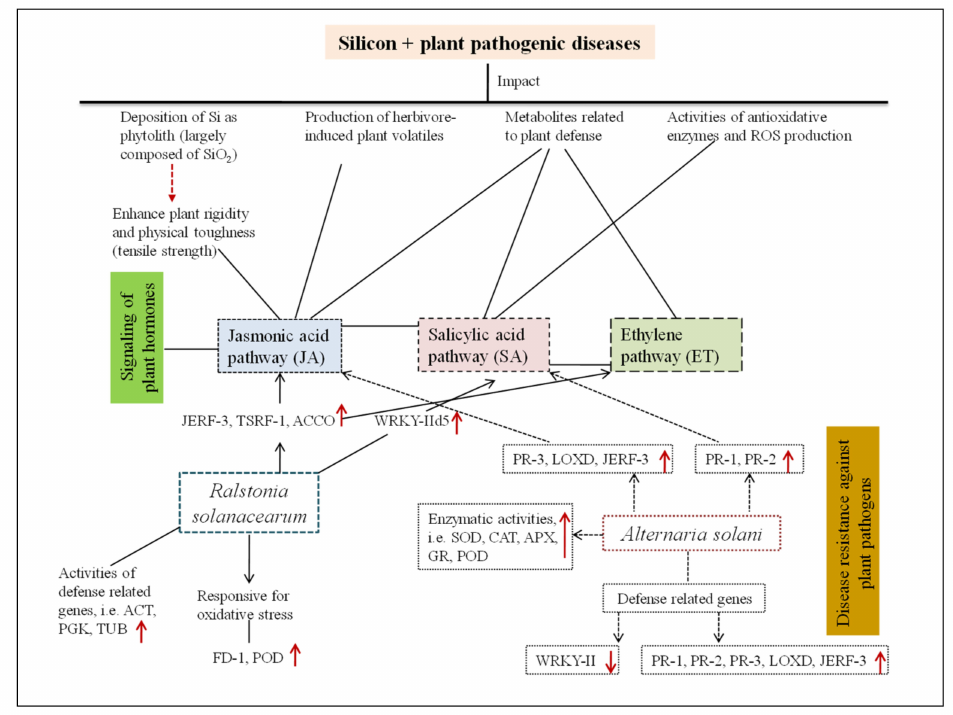
Figure 2. The systematic summary of the Si-mediated regulation of central defense-related genes linked with mitigation of plant pathogenic diseases, i.e., biotic stress. PR-1, PR-2, PR-3—pathogenesis- related proteins; JERF—Jasmonate and ethylene-responsive factor 3; TSRF—tomato